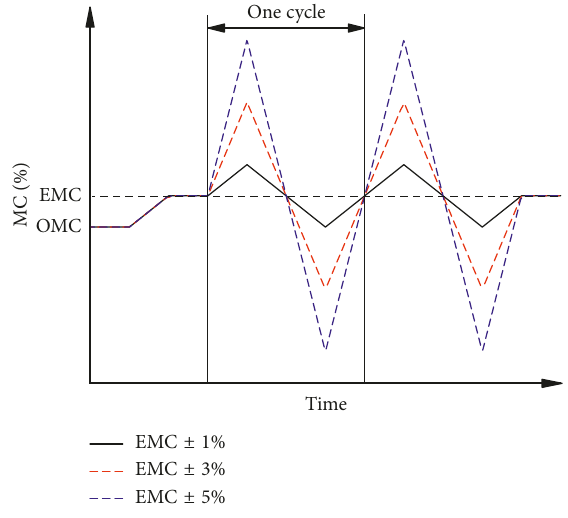
Figure 1: Wetting-drying path.